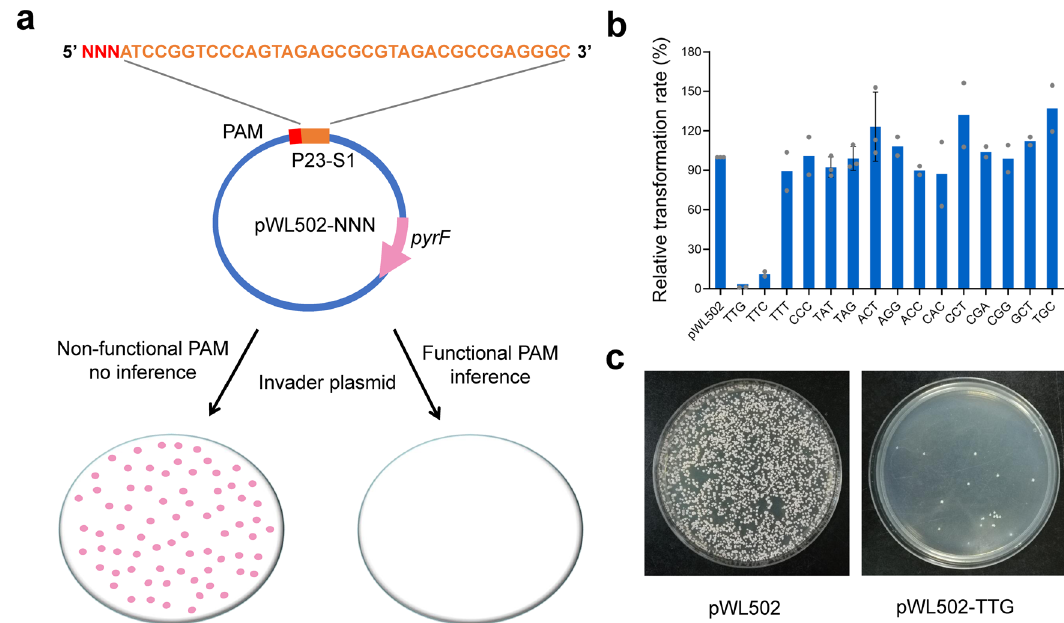
Fig. 2 Plasmid-based invader assay for identi fi cation of functional PAMs. a The schematic representation of the plasmid-based invader assay. Potential PAM sequences (NNN) are introduced upstream of the spacer sequence P23-S1 (orange letters) and then inserted into pWL502 yielding invader plasmids pWL502-NNN. DF50 Δ EPS is transformed with invader plasmids and selected on AS-168SY plates without uracil. Only the cells containing the invader plasmid with a non-functional PAM could grow on the plates. No cell growth indicates that the invader plasmid carries a functional PAM which leads to interference and degradation of the invader plasmid. b Relative transformation rates of PAM constructs. Transformation rates are calculated as the number of transformants/ μ g DNA. The transformation rate of pWL502 is used as the positive control. Data shown for two or three biological replicates. Error bars indicate SDs, n = 3. c Colonies obtained by transformation of 1 μ g of plasmid pWL502 or